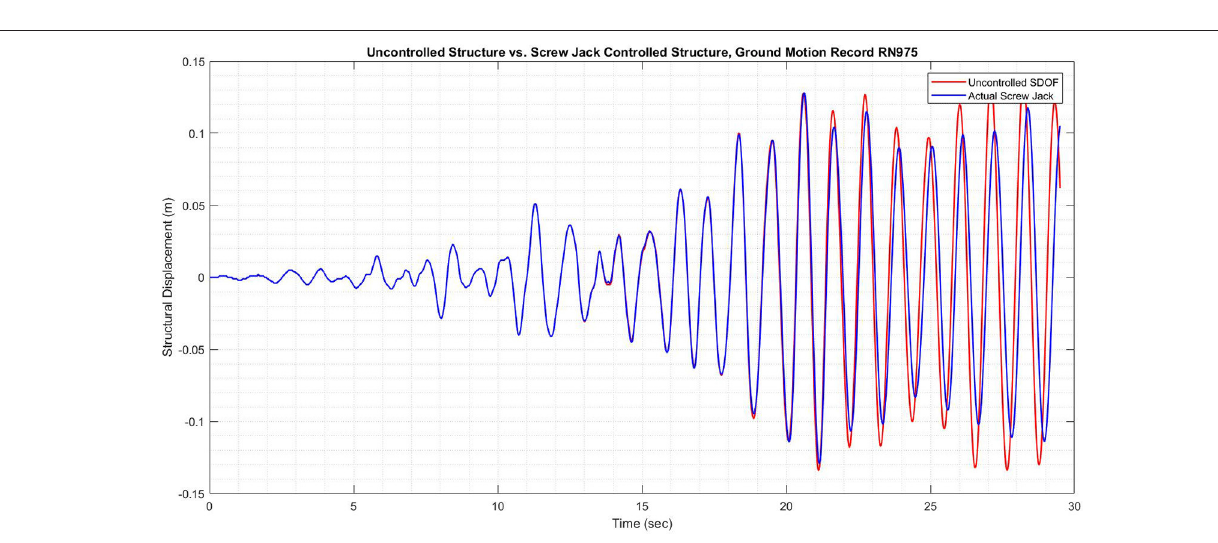
FIGURE 11 | Results of LSM showing structural displacement with and without screw jack for record